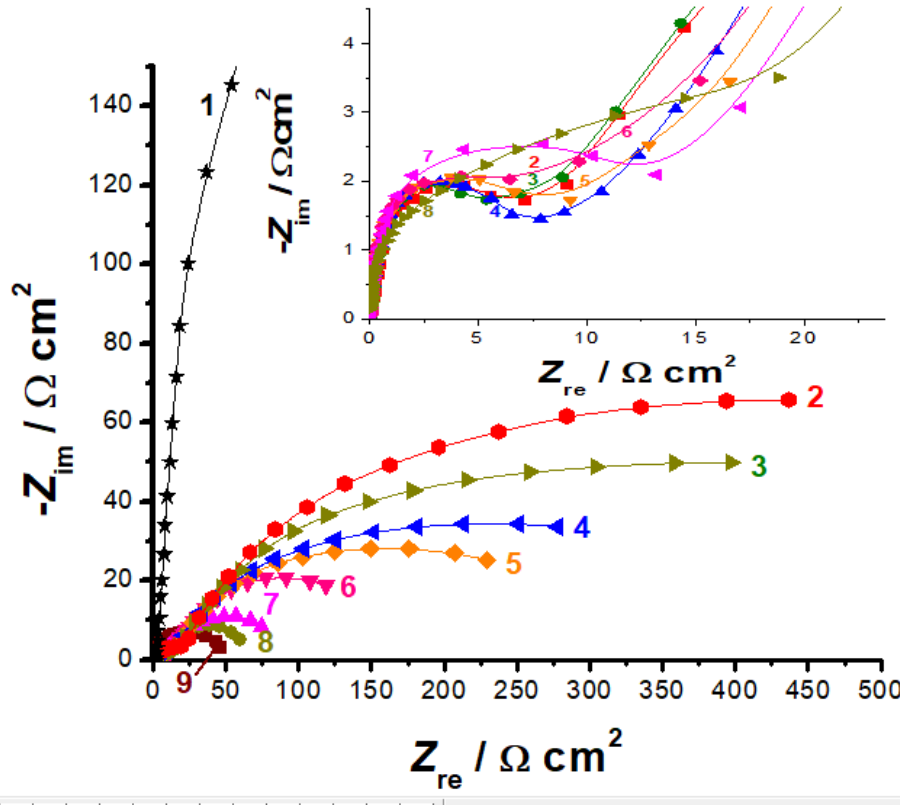
Figure 12. Complex-plane impedance plots recorded for the investigated Zn3 of various loading densities (unsupported and supported on GO) in a comparison with the supporting material (GO). Measurements were conducted in 0.1 M KOH aqueous solution at an overpotential value of 500 mV at room temperature. (1) Bare GC electrode; (2) GC − GO; (3) GC − Zn3 (0.2 mg cm − 2 ); (4) GC − Zn3 (0.4 mg cm − 2 ); (5) GC − Zn3 (0.8 mg cm − 2 ); (6) GC − Zn3 (0.2 mg cm − 2 )/GO; (7) GC − Zn3 (0.4 mg cm − 2 )/GO; (8) GC − Zn3 (0.8 mg cm − 2 )/GO; (9) Pt/C. Inset—the high frequency region to clarify the presence of the small